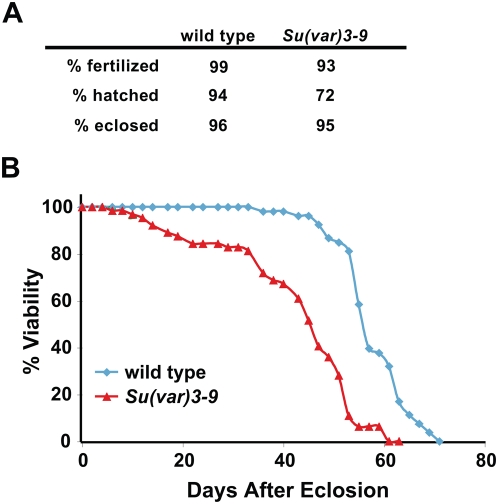
Developmental progression and lifespan of wild type and Su(var)3-9 animals.A) Analysis of developmental progression for wild type and Su(var)3-9 animals. Animals in the two groups laid comparable numbers of eggs. In all three assays, the p values comparing Su(var)3-9 to wild type are <0.001 by Student's t test. n>150 for each genotype. B) The graph shows lifespan analysis of wild type and Su(var)3-9 adult female flies. Su(var)3-9 females displayed significantly shorter lifespan than wild type (p<0.01 by Wilcoxon signed rank test). n>50 female flies.